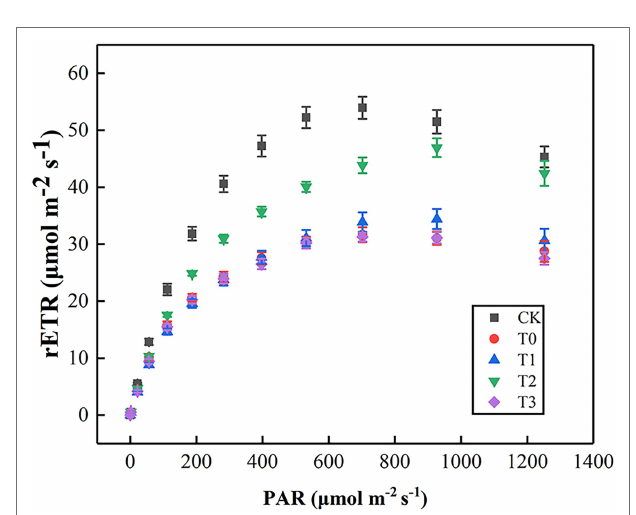
FIGURE 4 | Effect of different concentrations of trehalose on the light response curve of tomato leaves. Data were recorded after 5 days of treatment. The results showed the mean ± SE of three replicates. CK, control; T0, 150 mM NaCl; T1, 150 mM NaCl +5 mM trehalose; T2, 150 mM NaCl +10 mM trehalose; T3, 150 mM NaCl +25 mM